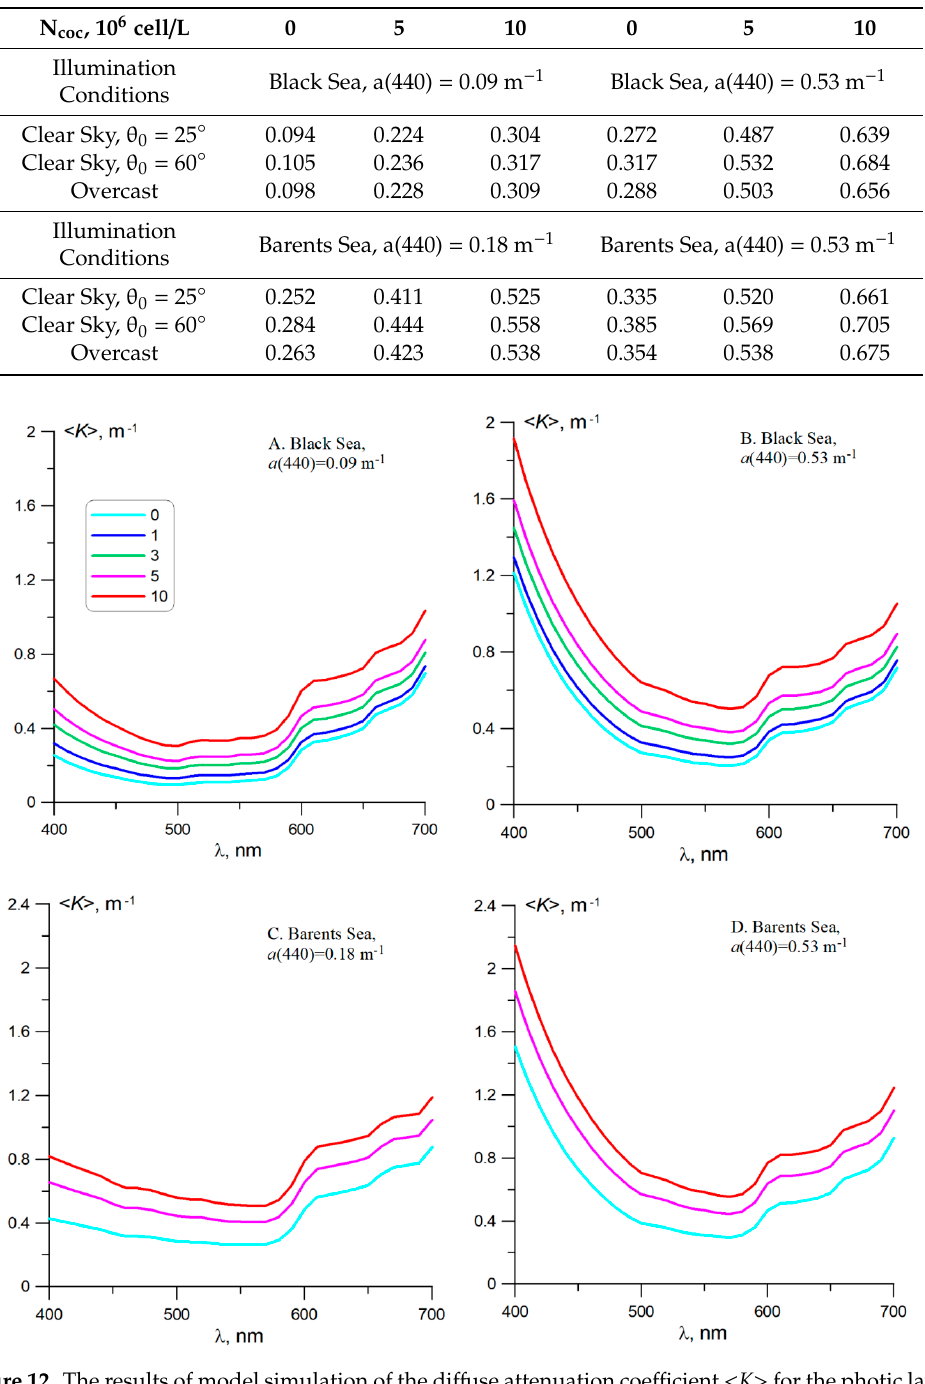
Table 6. The value of < K > (500) m − 1 for the cases of the Black Sea and Barents Sea, depending on the value of N coc , illumination conditions, and the absorption coe ffi cient.